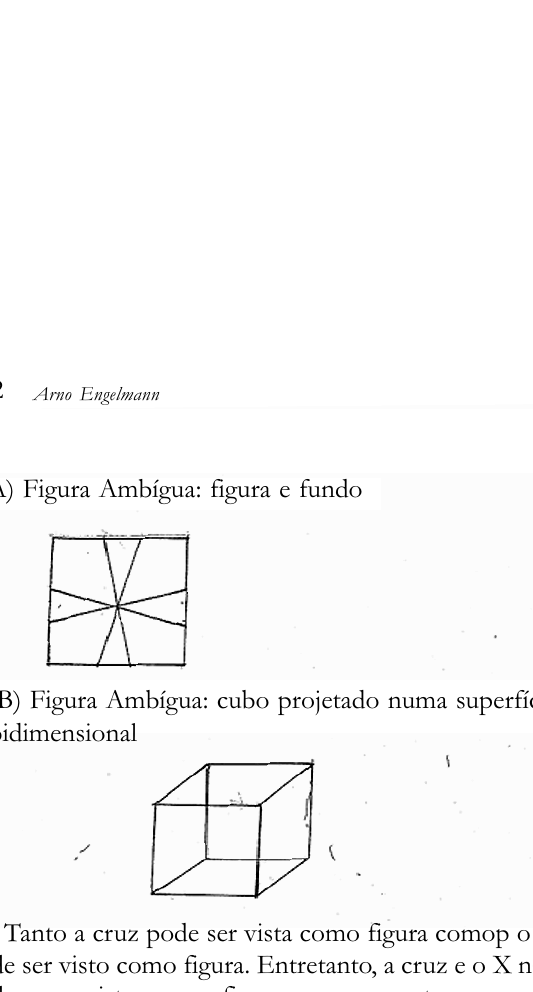
(A) Tanto a cruz pode ser vista como figura comop o X pode ser visto como figura. Entretanto, a cruz e o X nªo podem ser vistas como figuras ao mesmo tempo. (B) O ponto da direita central Ø visto na frente ou o ponto da esquerda central Ø visto na frente. Entretanto, as duas visıes sªo imcompat(cid:237)veis no mesmo Figura 3. Visıes das